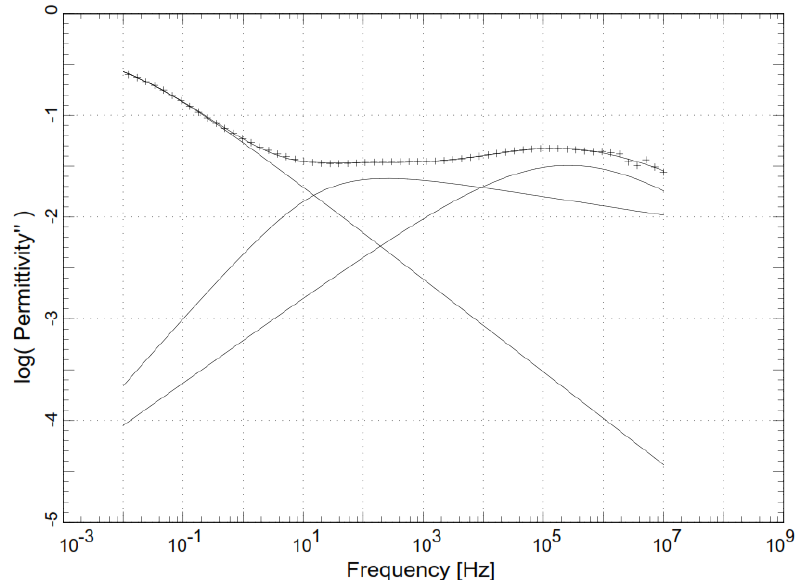
Figure 1. Example of HN fitting functions.